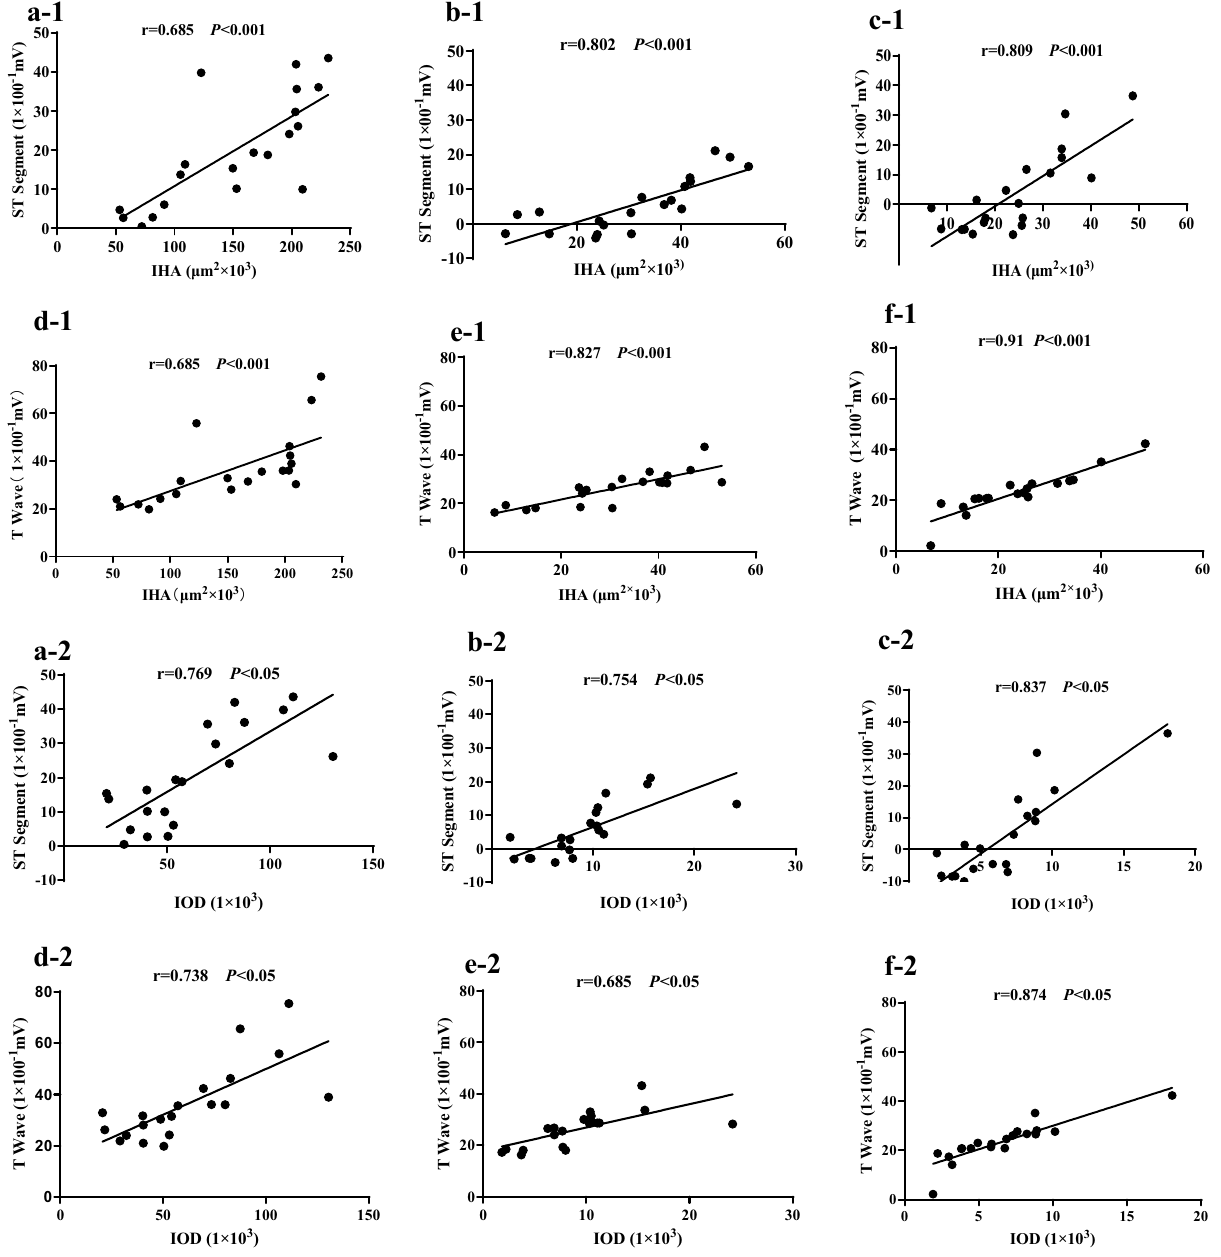
Figure 5. Correlation analysis of ST segments and T waves with HBFP staining. The results of correlation analysis of ST segments ( a – c ) and T waves ( d – f ) with HBFP staining in group EE ( a , d ), group EEP + EE ( b , e ) and group LEP + EE ( c , f ). The results suggested that ST segments and T waves on ECG had a strong positive correlation with HBFP